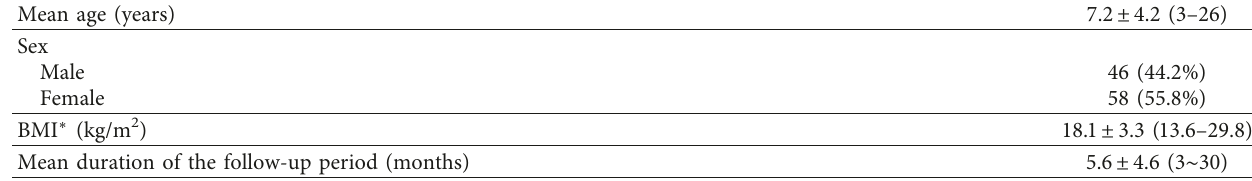
Figure 2: Modified epiblepharon repair preserving orbicularis oculi muscle. Skin incision line was made 1-2 mm below the ciliary line just below the lower punctum with lateral extension (a) Dissection was performed between the tarsus and the pretarsal orbicularis muscle (b) A small amount of pretarsal orbicularis muscle was excised (c) Eyelash rotating sutures were placed between the subcutaneous tissue of the upper skin flap and the tarsal plate in three to five points with 7–0 nylon sutures (d) To preserve the pretarsal orbicularis muscle, the skin flap was undermined carefully (e) An excess skin flap was excised (f) Medial dense fibrotic tissue and orbicularis muscle were removed under the skin flap (g) The skin was closed in a continuous manner Table 1: Characteristics of the 104 participating patients (208 eyes).